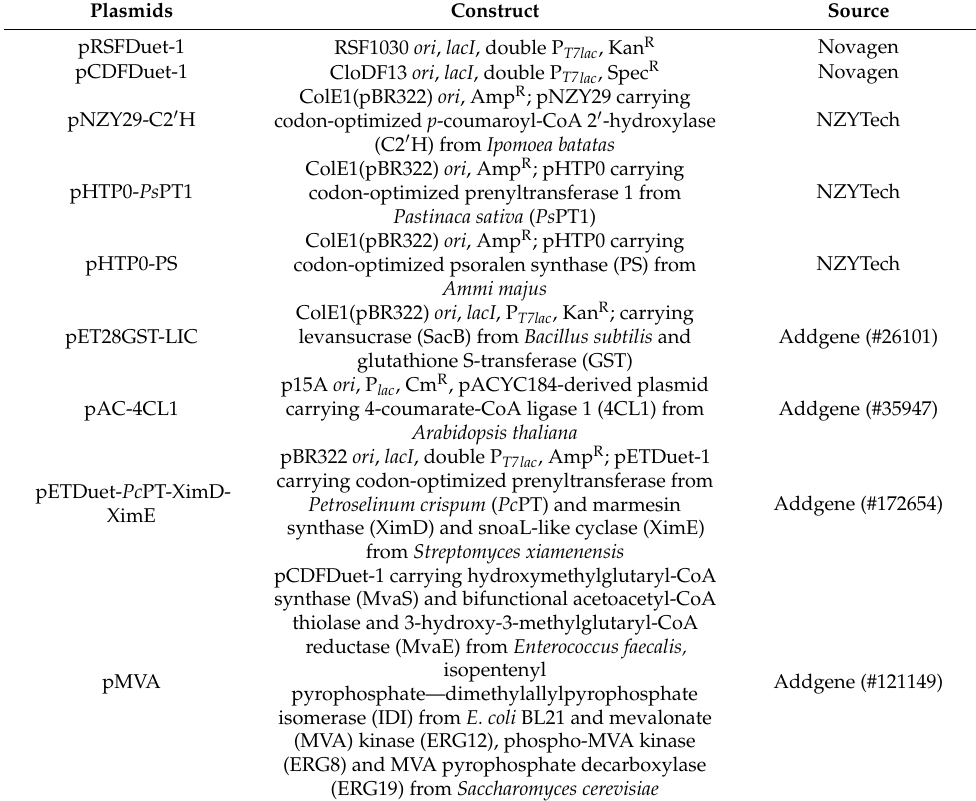
Table 1. Plasmids used in this